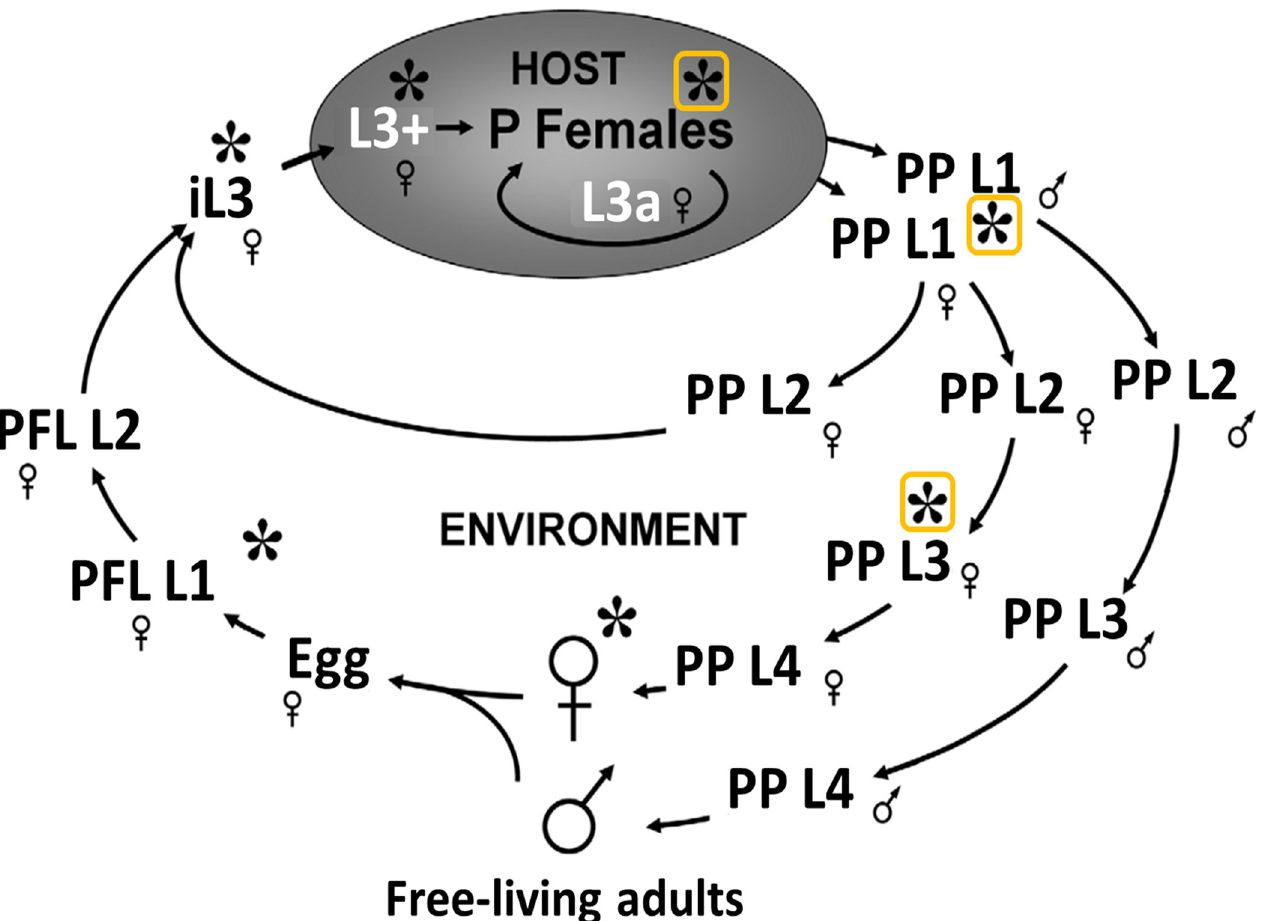
Fig 2. Strongyloides stercoralis life stages. Asterisks indicate life stages for which transcriptomic data were obtained by Stoltzfus et al . (2012). We grouped these transcriptomic data by presence in the host gut (boxed asterisks), and outside the host gut. P Females, parasitic females; PP, post parasitic; FL, Free-living; PFL, post free-living; L1, stage 1 larva; L3, stage 3 larva; iL3, infectious third stage larva; L3+, tissue-migrating larva; L3a, autoinfective L3. Figure modified from Stoltzfus et al . (2012) [37] under a CC BY license. Accession numbers are given for NCBI SRA for the triplicate reads in Table 1. numbers, were extracted from the resulting table and duplicated hits removed. Corresponding S .